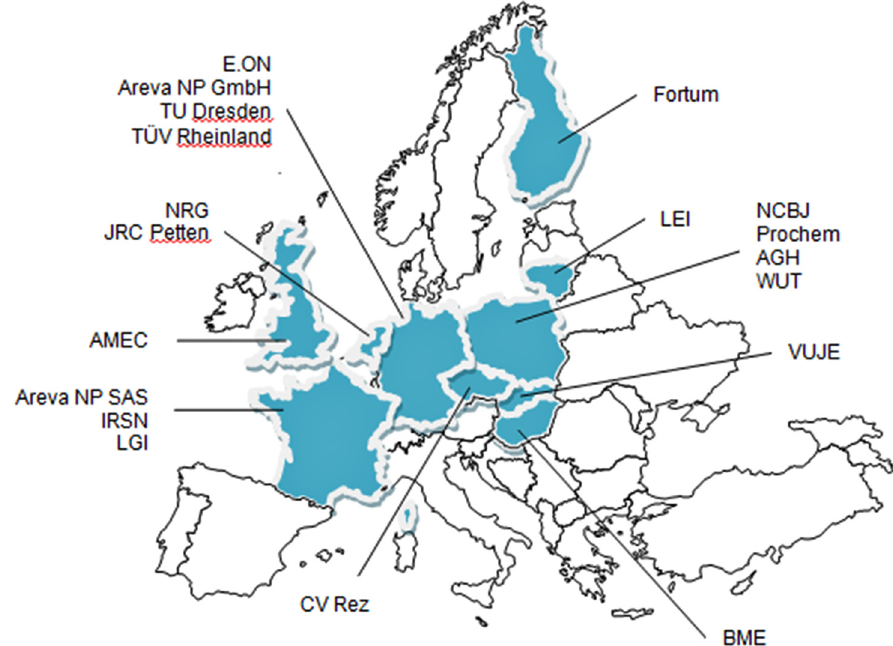
Fig. 3. NC2I-R partners. NorthWest University from South Africa also